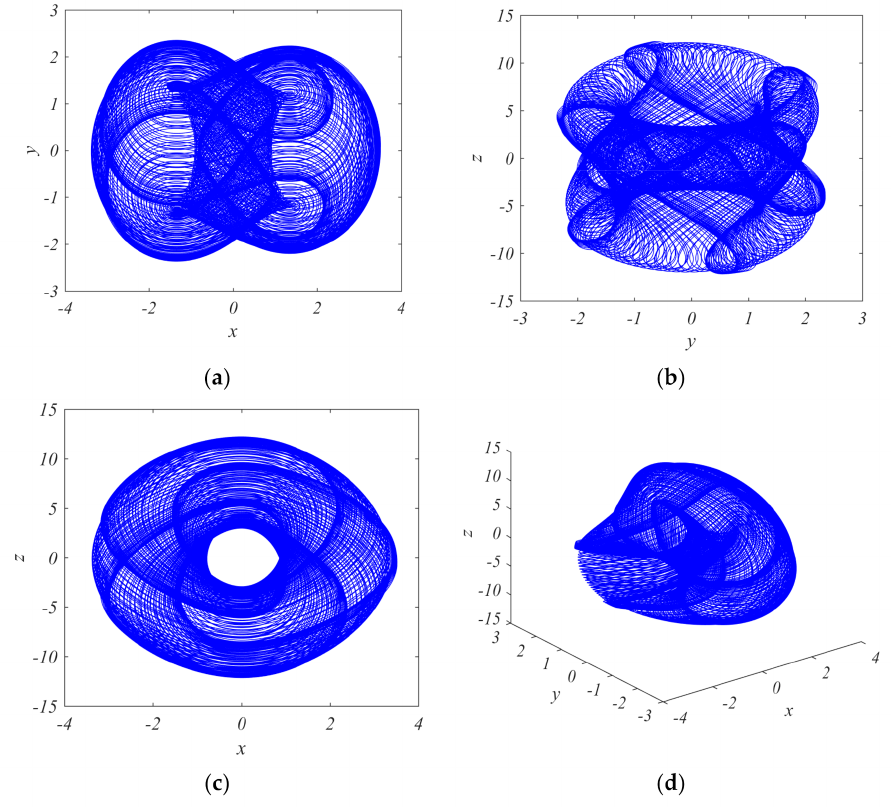
Figure 2. System (Equation (5)) phase portraits: ( a ) x - y chaotic attractor; ( b ) y - z chaotic attractor; ( c ) x - z chaotic attractor; ( d ) three-dimensional chaotic